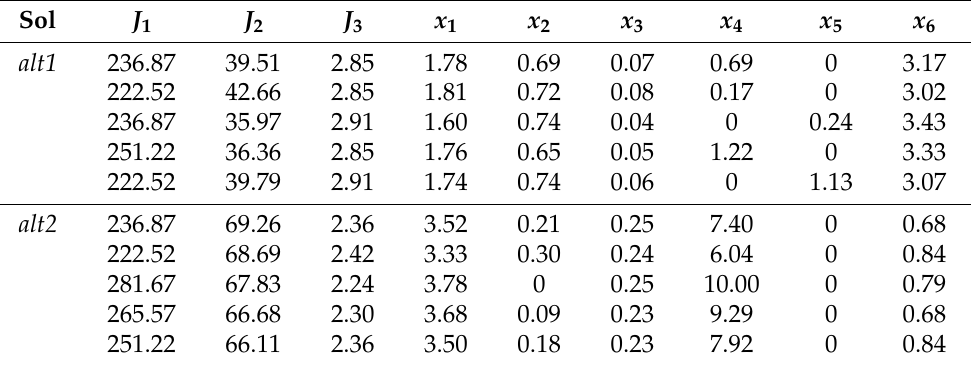
Table 1. alt1 : The five nearest points to ideal point without considering preferences. alt2 : The five nearest points to ideal point considering preferences.